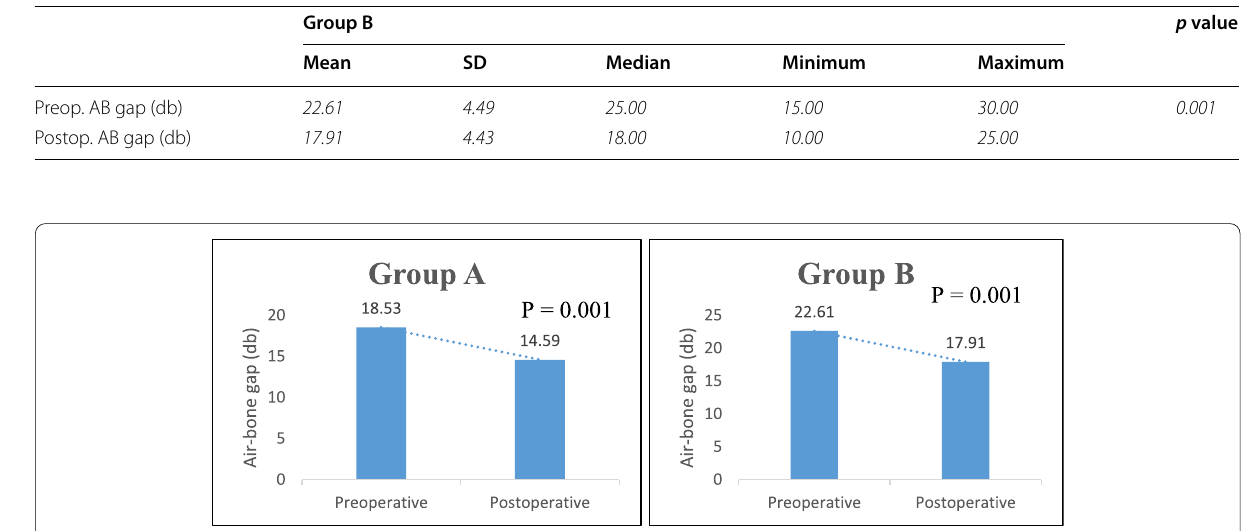
Table 3 Comparison between preop. and postop. AB gap in group B